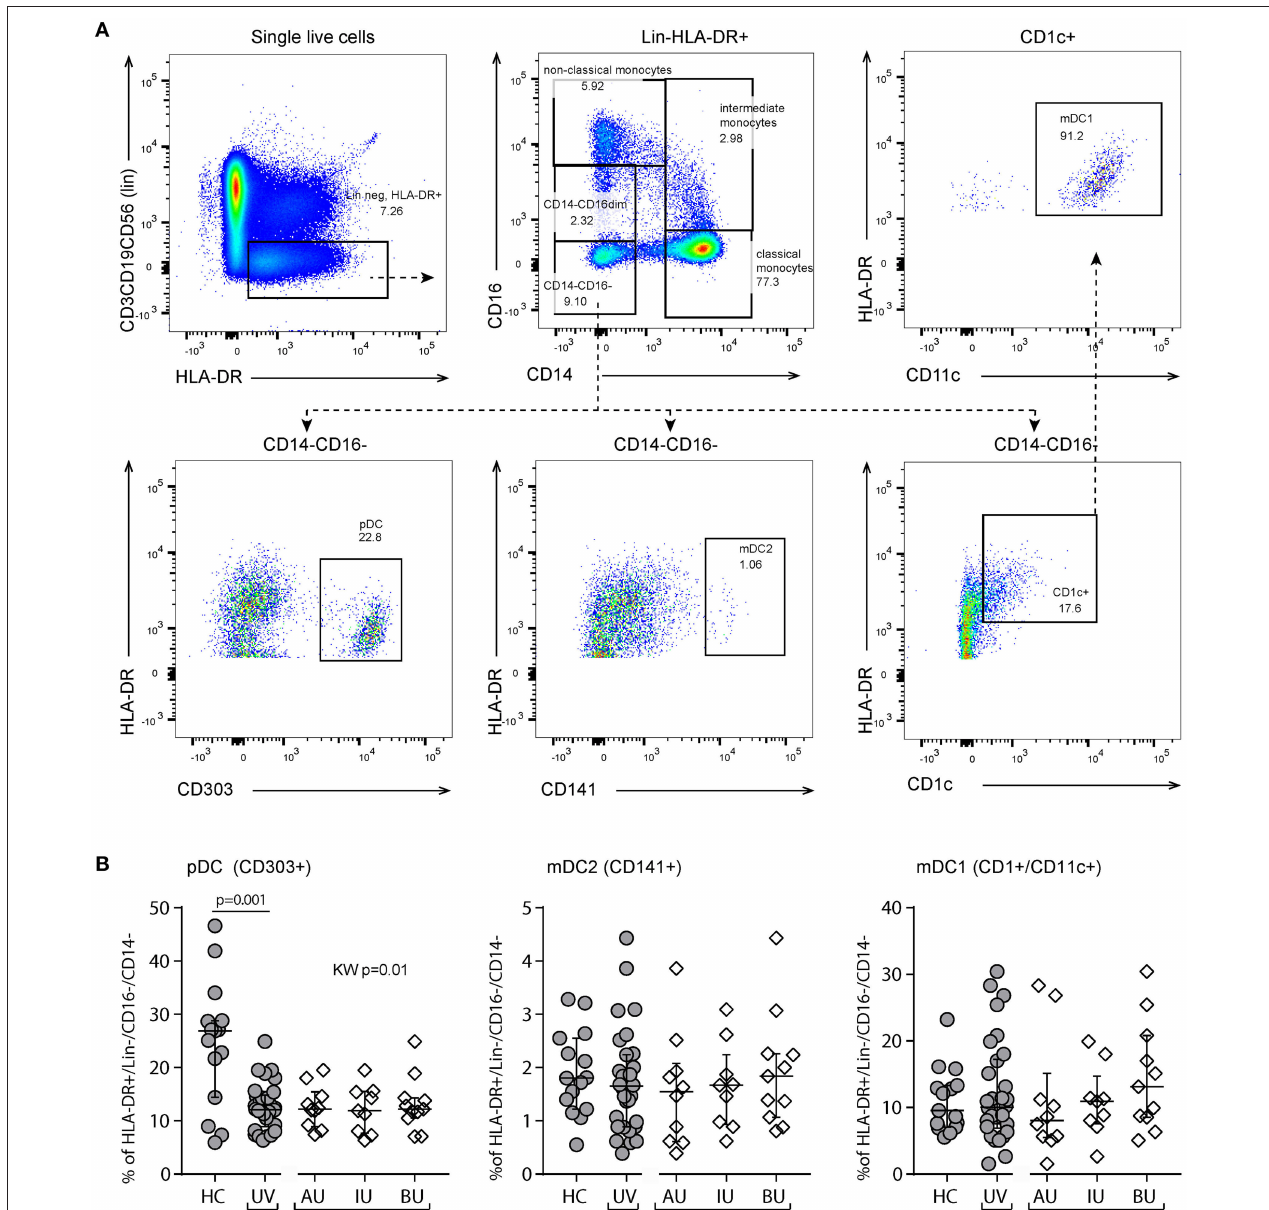
FIGURE 5 | Flow cytometry of peripheral blood mononuclear cells shows a decrease of plasmacytoid dendritic cells in non-infectious uveitis. (A) Gating strategy used to identify dendritic cell subsets (representative sample). Live single cells are gated as indicated in Figure S1 . (B) The frequency of circulating plasmacytoid and myeloid dendritic cell subsets as percentage of the HLA-DR + Lineage (CD3,CD19,CD56) − CD16 − CD14 − cells. Bars in plots indicate median, error bars indicate interquartile range. P -values between HC and UV are from Wilcoxon rank-sum test, p -values between uveitis subgroups are from Kruskal–Wallis (KW) test with post-hoc Dunn’s correction for multiple testing. AU, HLA-B27 associated anterior uveitis; BU, Birdshot uveitis; HC, healthy control; IU, idiopathic intermediate uveitis; KW, Kruskal–Wallis test; mDC, myeloid dendritic cell; pDC, plasmacytoid dendritic cell; UV, Combined Uveitis samples.